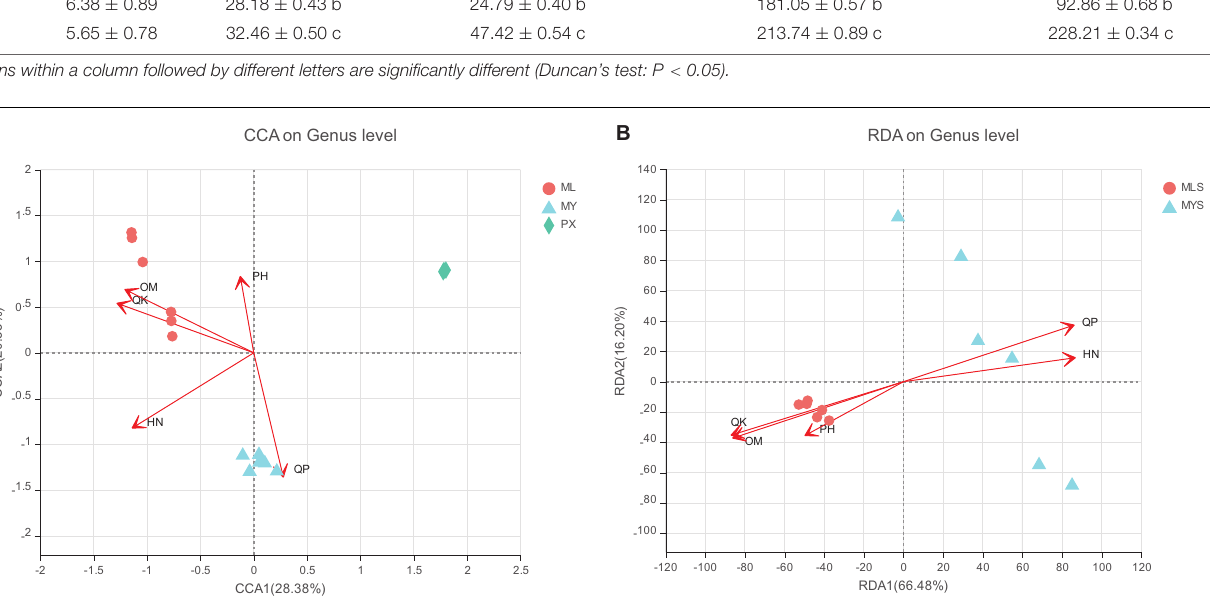
FIGURE 12 | (A) Redundancy analysis (RDA) of endophytic fungi. (B) RDA of the